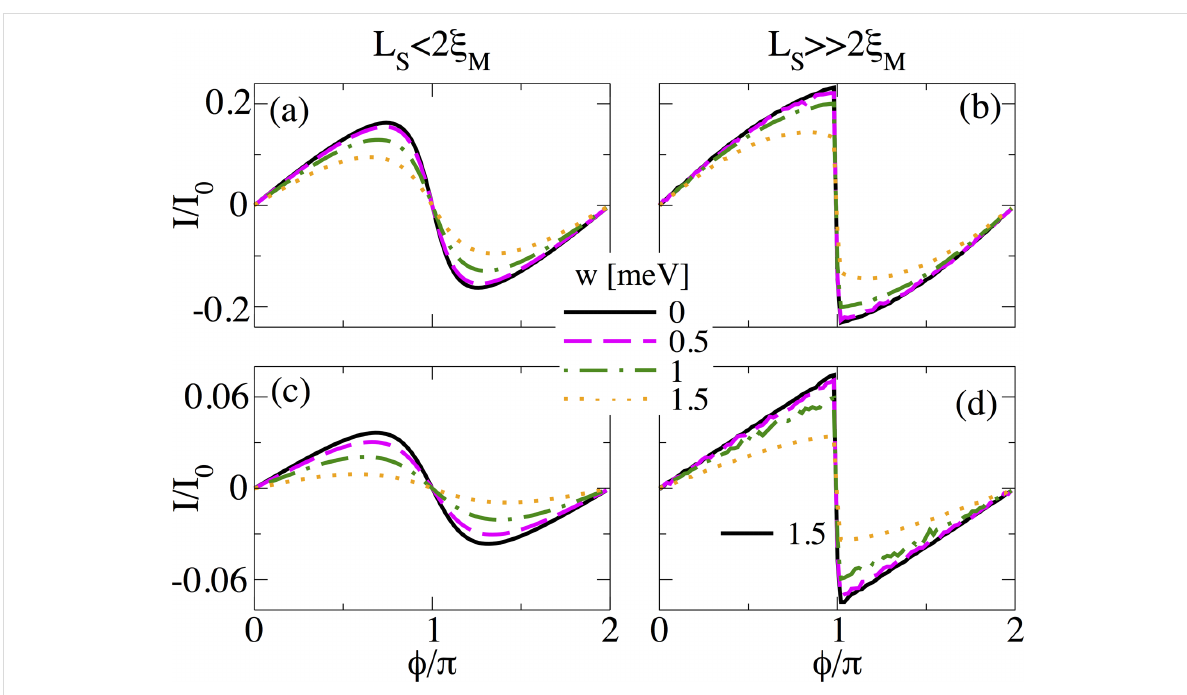
Figure 16: Effect of random on-site scalar disorder on the supercurrent I ( ) in (a,b) a short and (c,d) a long SNS junction at B = 1.5 B c . (a,c) L S = 2000 nm ≤ 2 ξ M and (b,d) L S = 10000 nm 2 ξ M . Each curve corresponds to 20 realizations of disorder, where w is the disorder strength. For small values of w of the order of the chemical potential, the sawtooth profile at = π is preserved (see right panel). Parameters: L N = 20 nm for short and L N = 2000 nm for long junctions, α R = 20 meV·nm, μ = 0.5 meV, Δ = 0.25 meV and